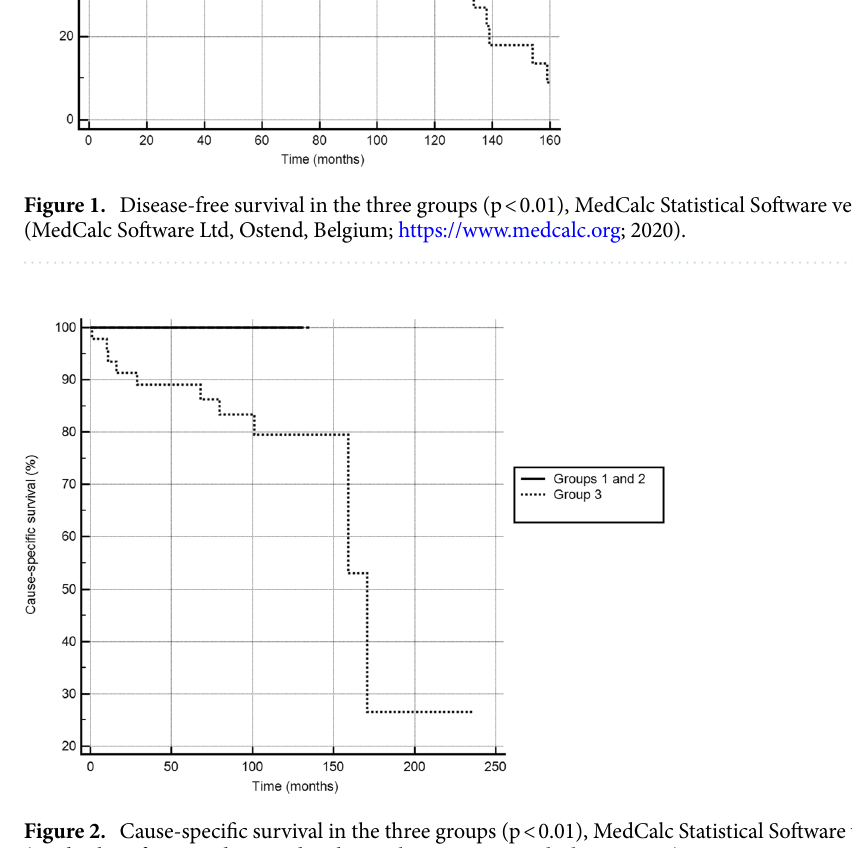
Figure 2. Cause-specific survival in the three groups (p < 0.01), MedCalc Statistical Software version 19.1.7 (MedCalc Software Ltd, Ostend, Belgium; https:// www. medca lc. org;